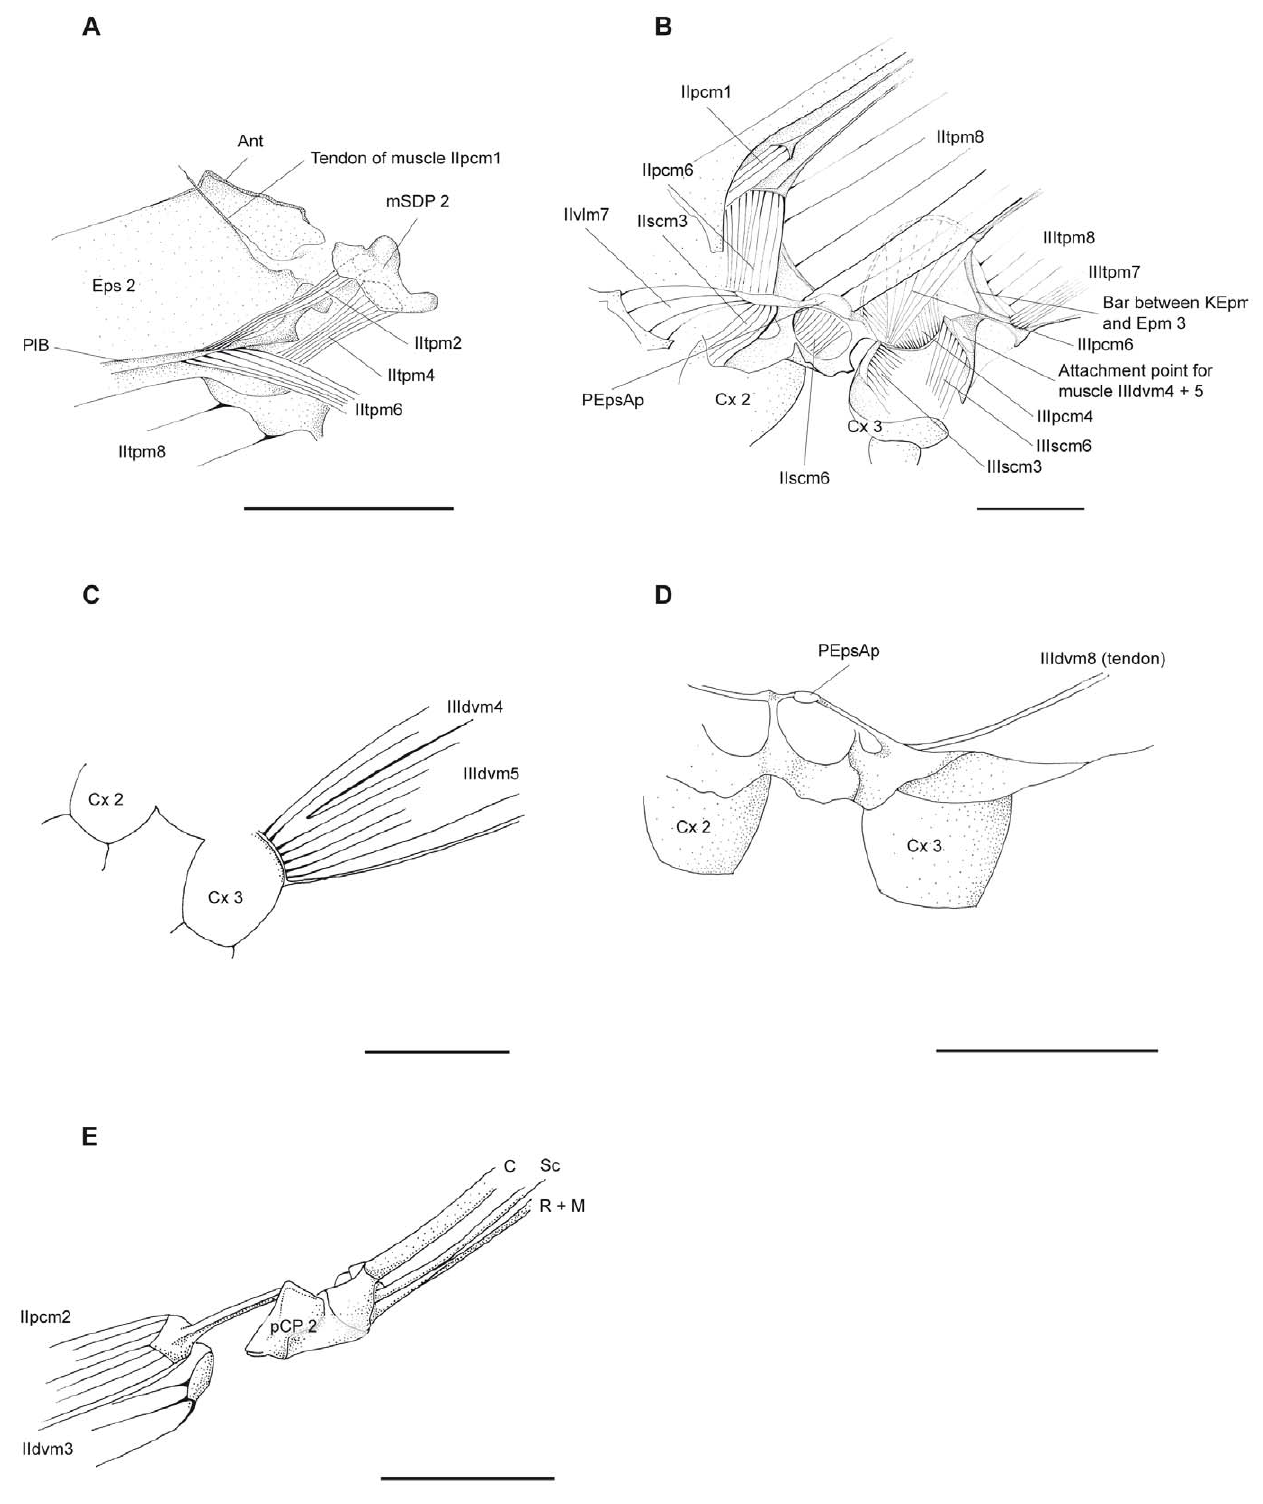
Figure 7. P.nymphula , details of muscle attachements. A–D Longitudinal section, right. A Attachments point of muscles IItpm4, IIItpm4, IIItpm6 and IItpm8. B Ventral thorax musculature. C Points of origin of muscles IIIdvm4 and IIdvm5. D Point of origin of muscle IIIdvm8. E Detail of attachment points of muscles IIpcm2, IIdvm3. Dorsal view, right. Abbreviations: Ant – antealar plate, C – costa, Cx – coxa, Epm – epimeron, Eps – episternum, KEpm – katepimerom, M – media, mSDP - mediane semi-detached scutal plate, PEpsAp – preepisternal apodem, pCP - proximale costal plate, PIB – pleuralbar, R – radius, Sc – subcosta.